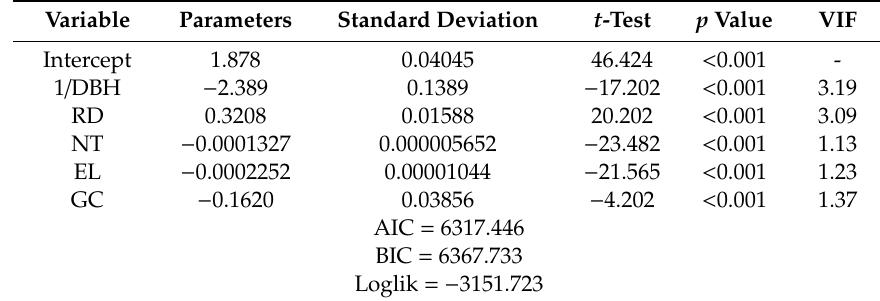
Table 2. Statistical analysis results of variables of the individual-tree basal area increment model for oaks.